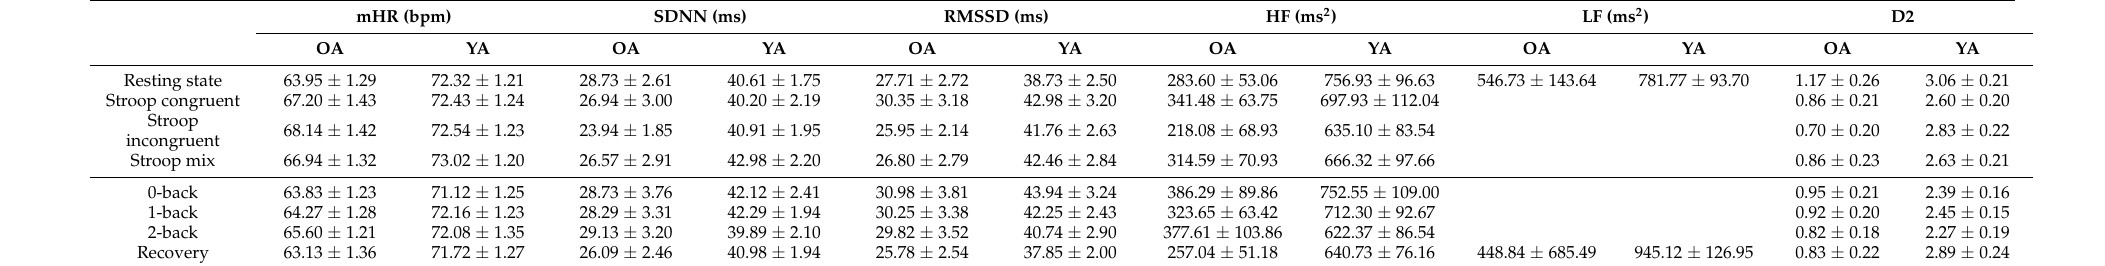
Table 2. Descriptive results for mHR and HRV measures (Mean ±